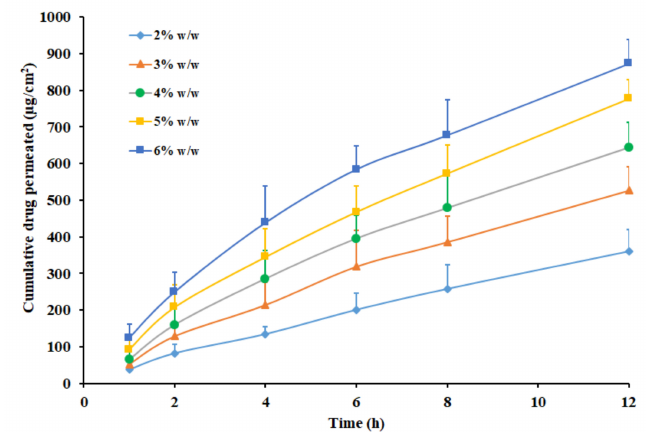
Figure 5. Amount of drug permeated across the rat skin membrane from Duro-Tak 87-2516 pioglitazone patch with propylene glycol at di ff erent drug level (2–6% w / w ). All values are mean ± SD ( n =